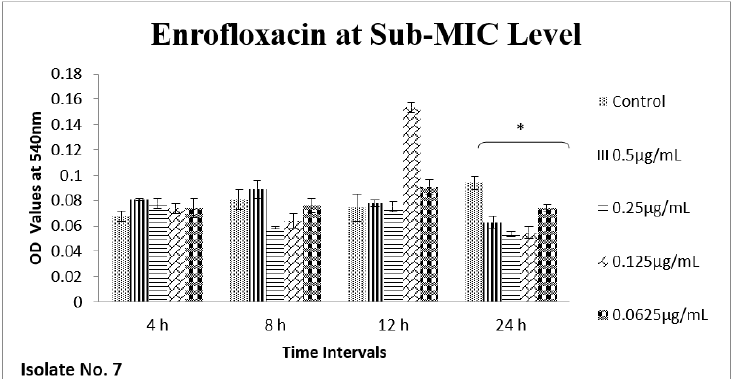
Figure 4. Shown are the effects of ceftriaxone on E. coli biofilms at different time intervals (OD 540 nm). Overall significant reduction (*** p value < 0.001) in biofilm formation was observed up to 24 h, when compared to the control samples.